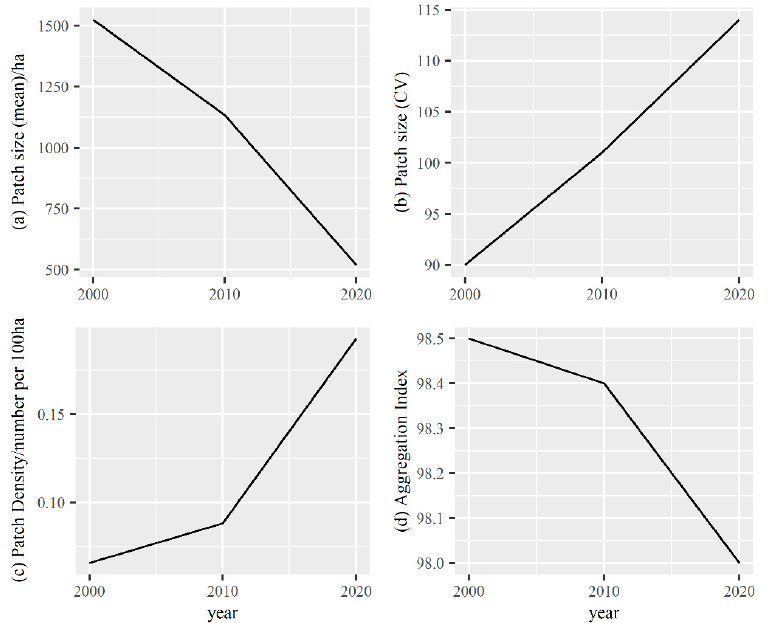
Figure 5. Pattern change of cropland from 2000 to 2020 for the Shandong Province. ( a ) Mean patch size; ( b ) patch size CV (coefficient of variation); ( c ) patch density; ( d ) aggregation index.